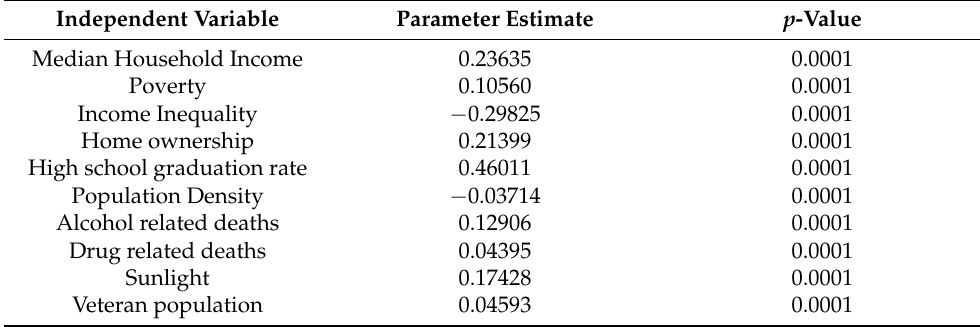
Table 1. Multiple Regression Model Results.